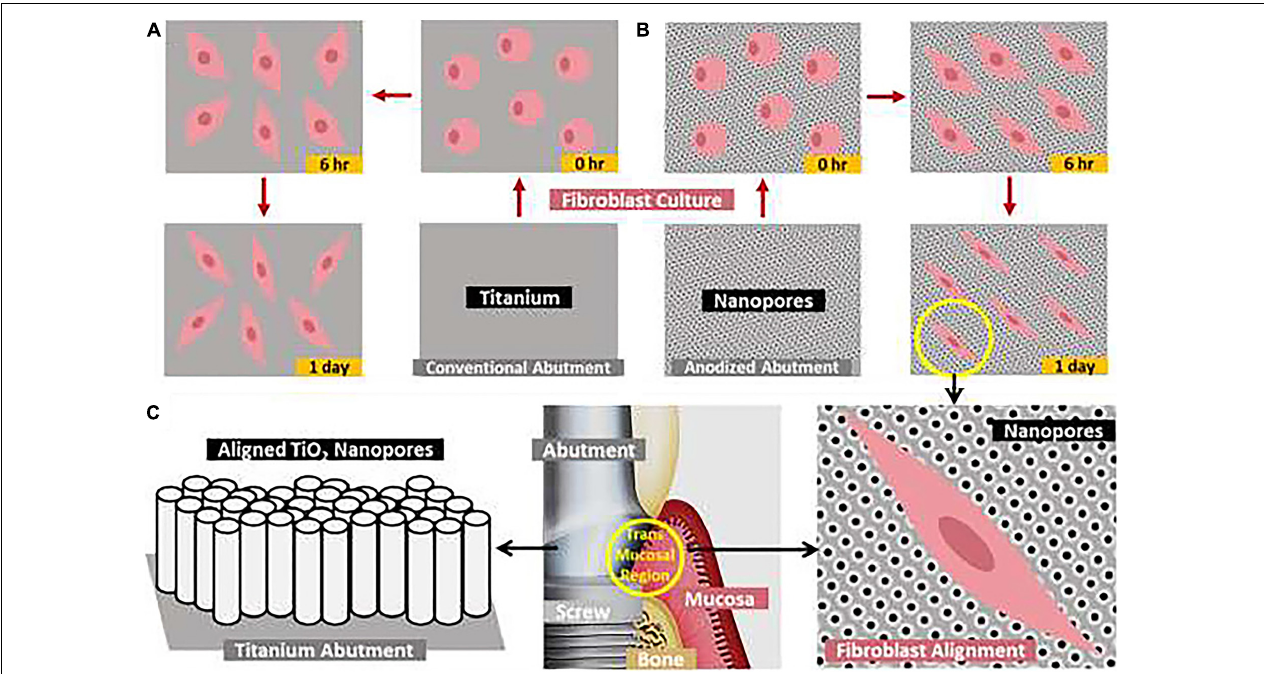
FIGURE 3 | Schematic representation of the nano-engineered titanium abutment with aligned TiO 2 nanopores/nanotubes toward augmented fibroblast attachment and aligning. Time-dependent attachment and spreading of fibroblasts on (A) conventional abutment and (B) electrochemically anodized abutment with aligned nanopores, (C) the proposed application of aligned nanopores toward augmenting the adhesion and alignment of fibroblasts at the transmucosal abutment-mucosa interface (yellow circle) (Gulati et al.,